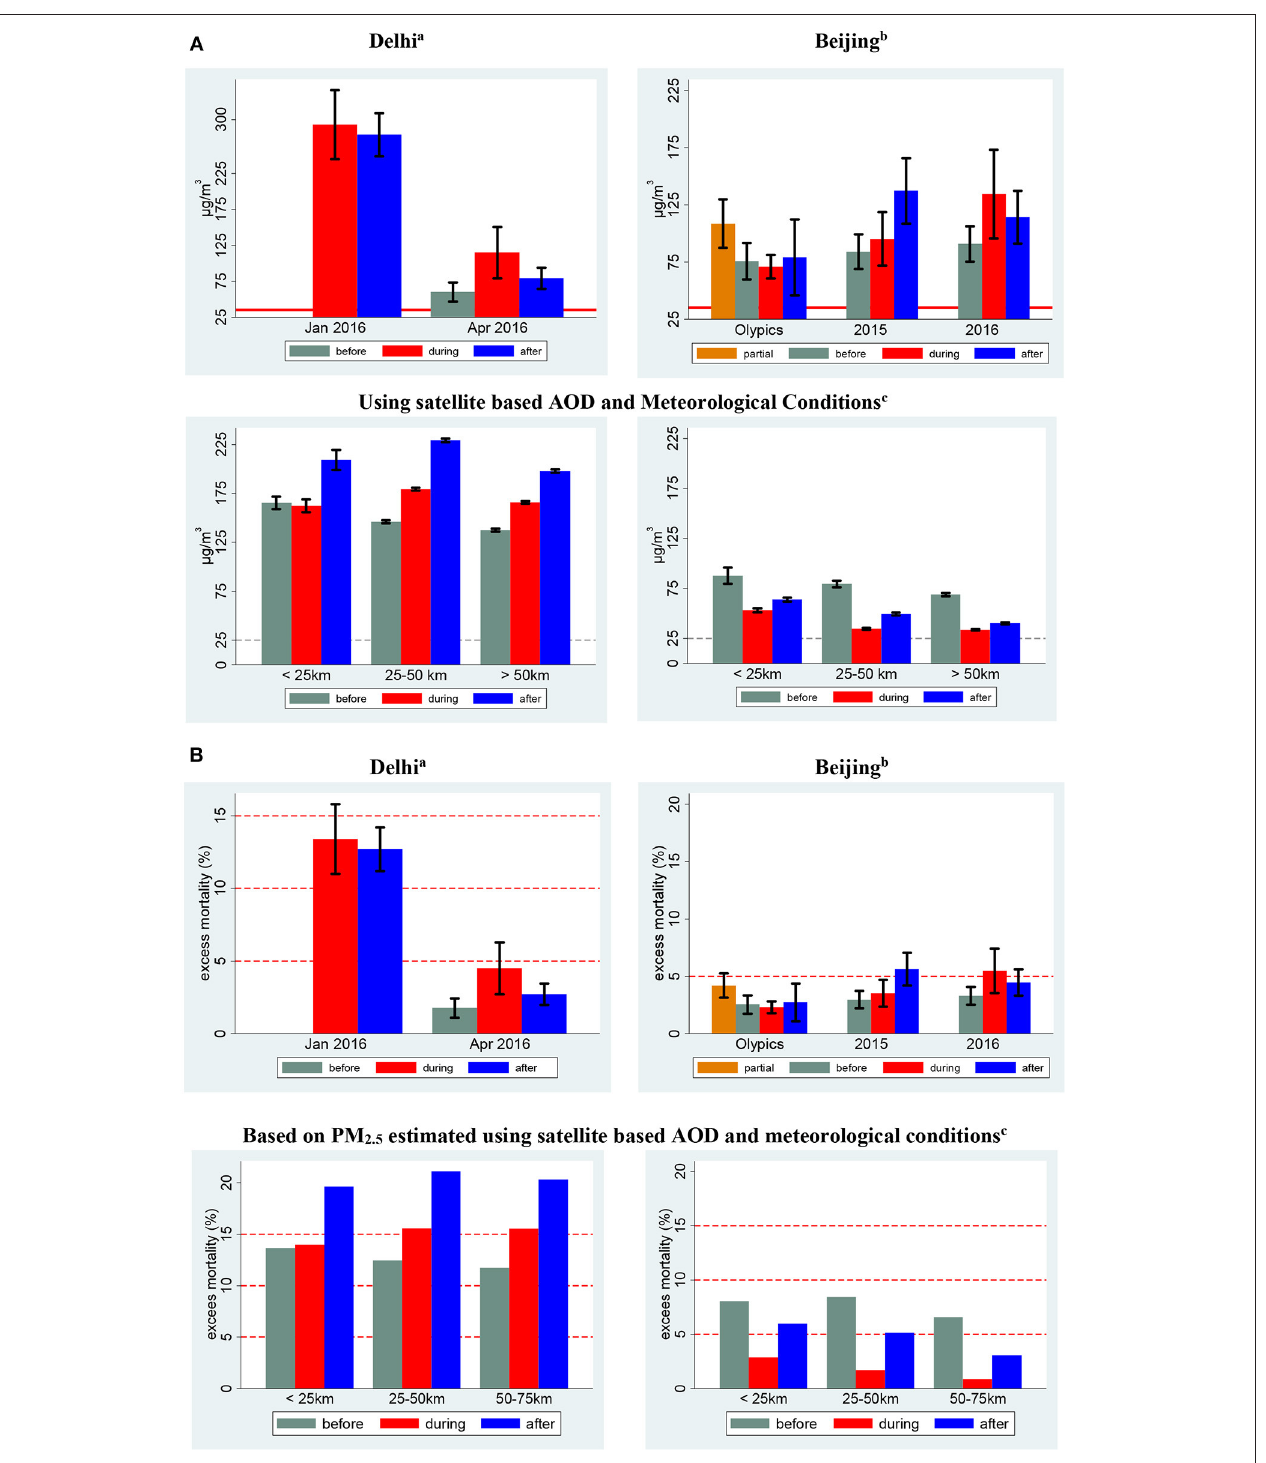
FIGURE 3 | (A) PM 2.5 ( µ g/m 3 ) concentration before, during and after vehicle rationing programs in Beijing and Delhi. (B) Mortality burden of airborne PM 2.5 concentration before, during and after the VRI. a Monitoring trial dates in Delhi refer to the following time frames: January − 01/01/2016 to 01/14/2016; April − 04/15/2016 to 04/30/2016. b Monitoring trial dates in Beijing refer to the following time frames: 2015 − 12/08/2015 to 12/11/2015, 12/18/2015 to 12/21/2015; 2016 − 12/16/2016 to 12/21/2016. c Satellite based estimates for Delhi were computed December 2015 and January 2016 and for Beijing before (06/30/2008 to 07/19/2008), during (07/19/2008 to 09/20/2008) and after (09/21/2008 to 10/05/2008) the 2008 Olympics.